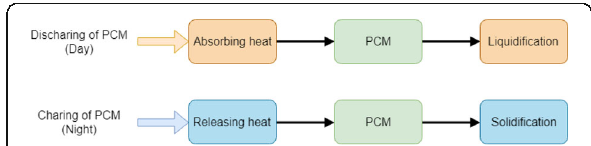
Fig. 3 (Abstract P7). Charging and discharging principle of the PCM.